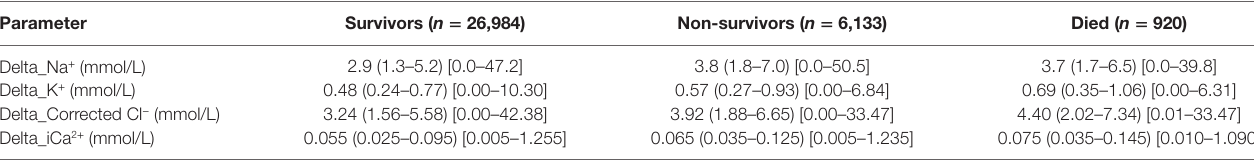
Table 2 | Summary delta electrolyte data.